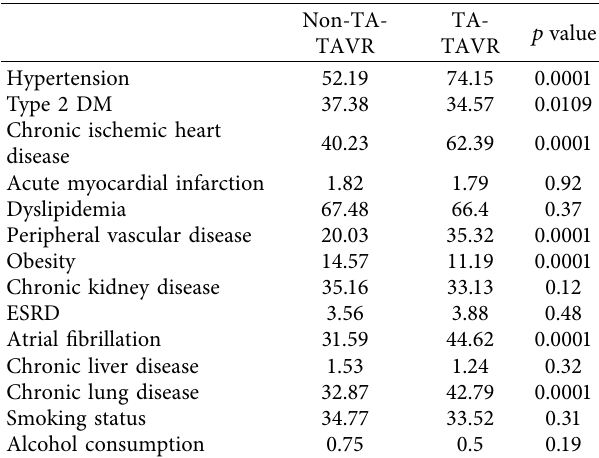
Table 2: Comorbidities of patients undergoing TAVR through transapical vs. nontransapical